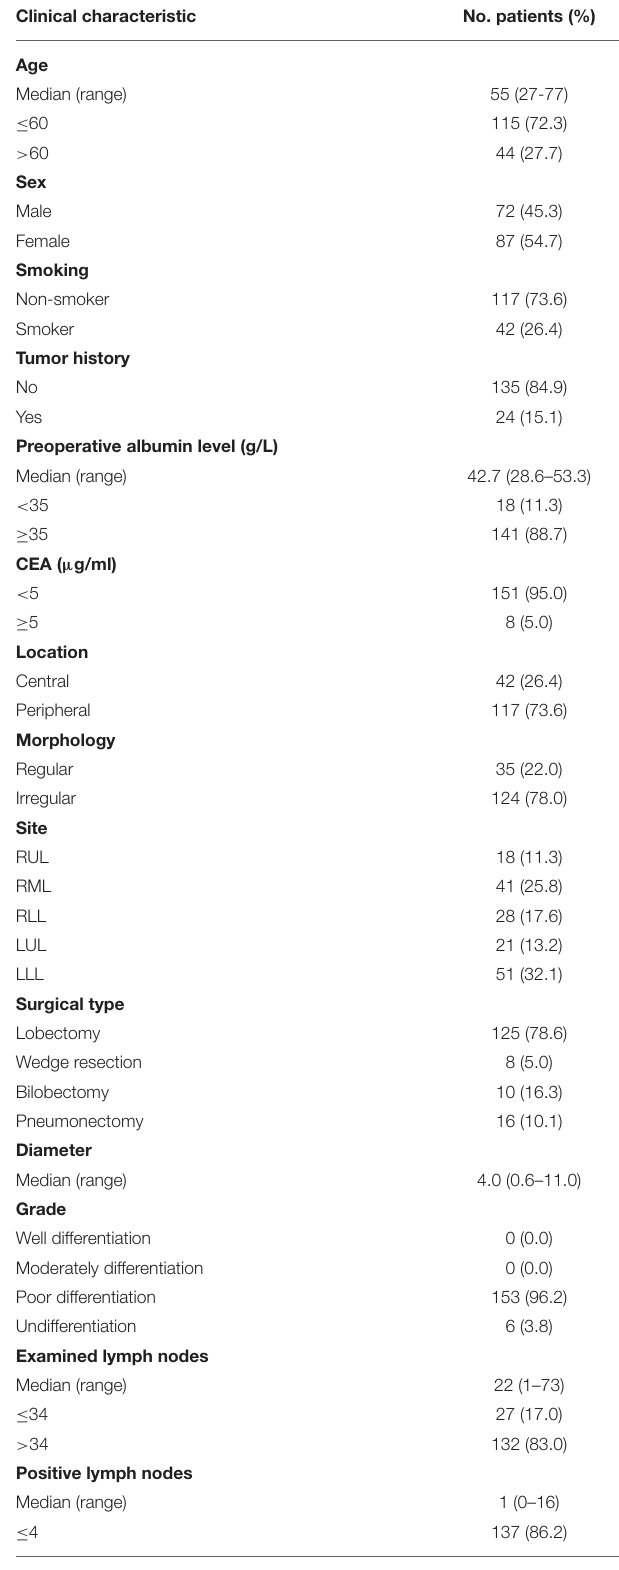
TABLE 1 | Clinicopathological characteristics of included LELC